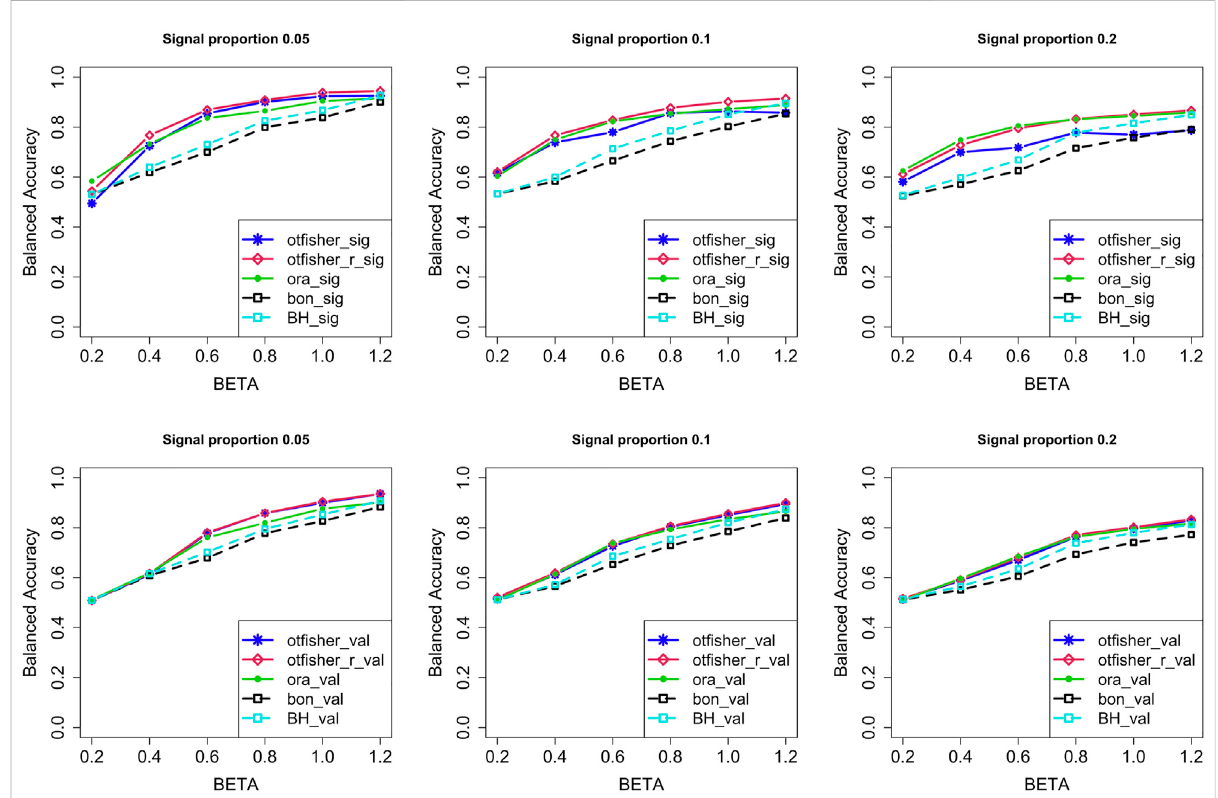
FIGURE 3 Thebalanced accuracyattheSNPscreening(row1)andvalidation(row2)stagesunderthecontinuoustraitmodel.Codeformethods:ot fi sher: the oTFisher procedure with threshold p + = τ *; ot fi sher_r, the oTFisher procedure with p + = min{ τ *, 0.1}; ora, the oracle procedure; bon, Bonferroni procedure; BH, Benjamini – Hochberg procedure; sig, screening stage; val, validation stage. Signal proportion is the proportion of causal SNPs in the two causal